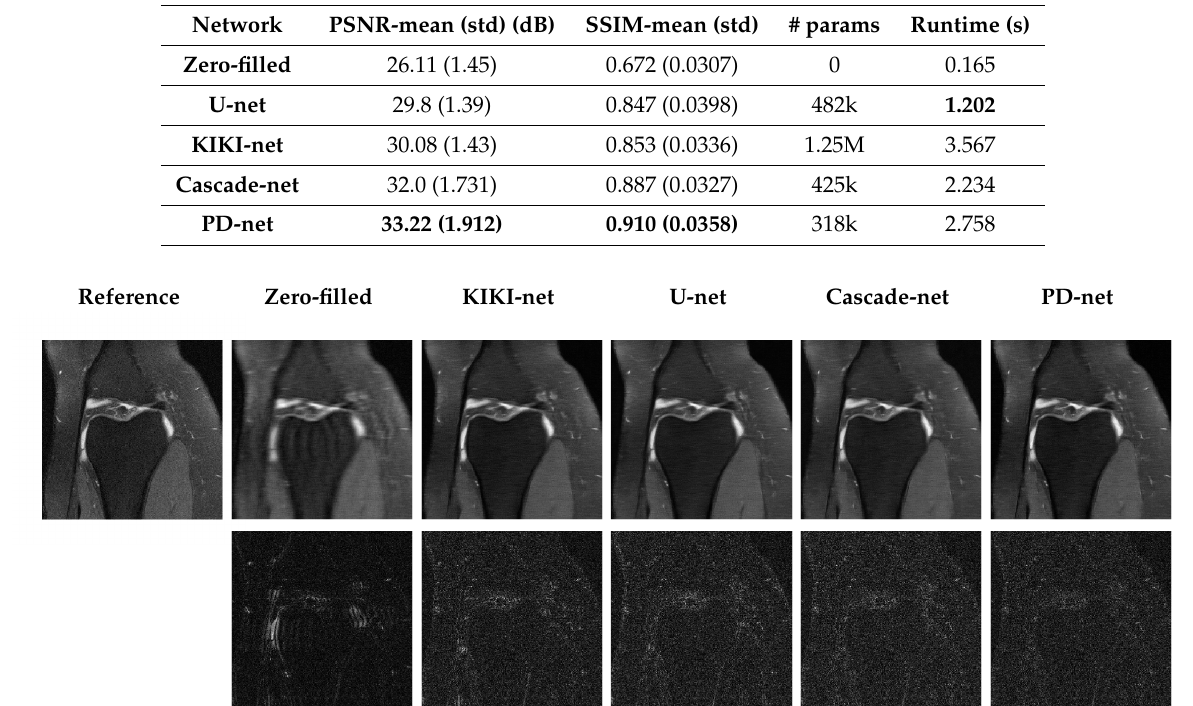
Figure 6. Reconstruction results for a specific slice (16th slice of file1000196 , part of the validation set). The first row represents the reconstruction using the different methods, while the second represents the absolute error when compared to the reference.